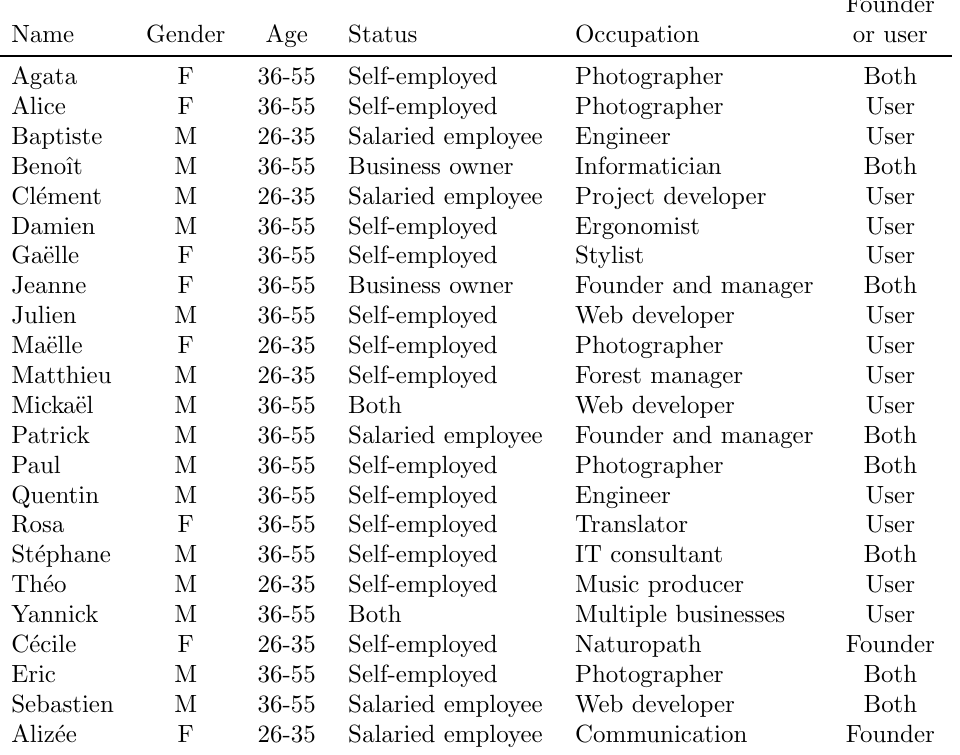
Table 2: Interviewees